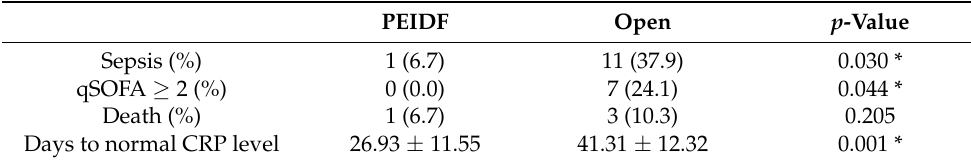
Table 2. Outcome